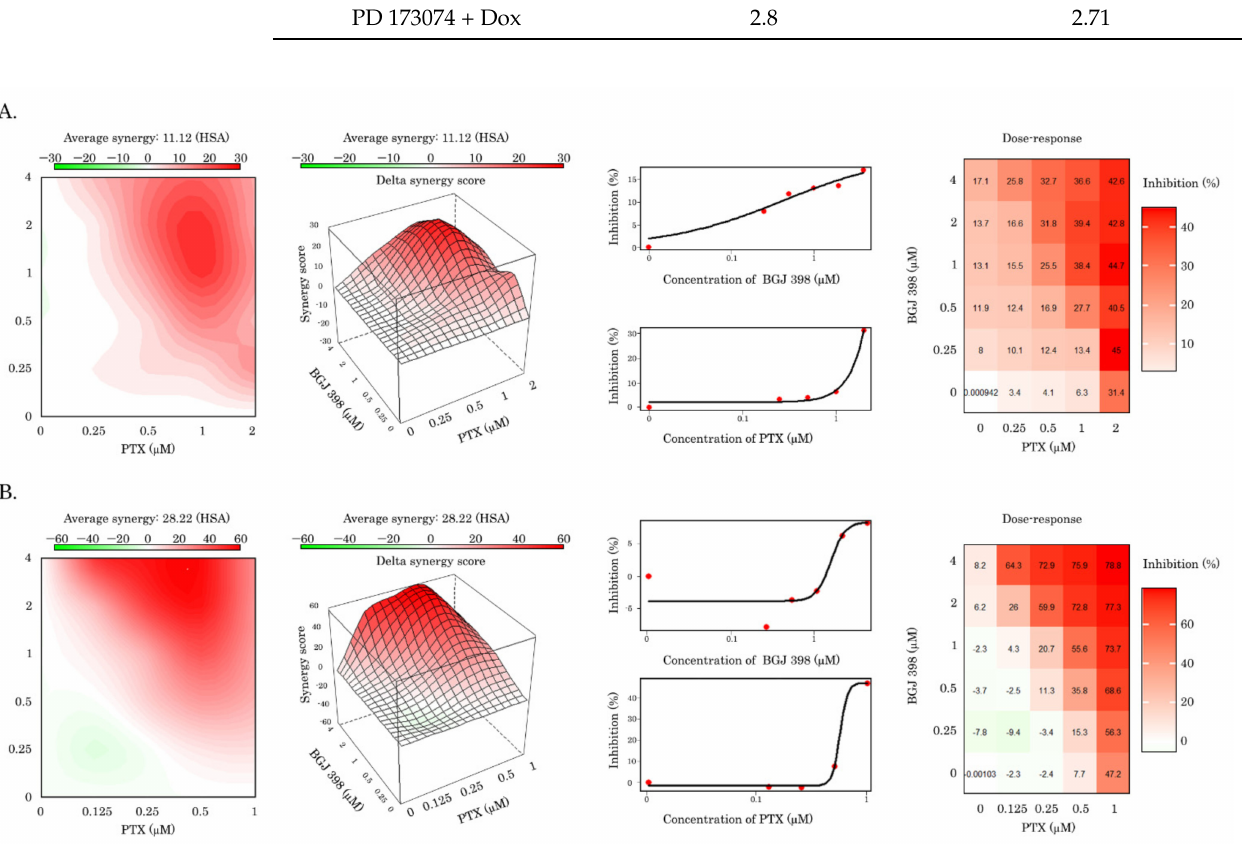
Figure 9. Assessment of the synergy between PTX and BGJ 398 in Tx-R HCC 1806 breast cancer ( A ) and GIST T-1 ( B ) cells. The average synergy for Tx-R HCC 1806 cells was 11.12, for GIST T-1 was